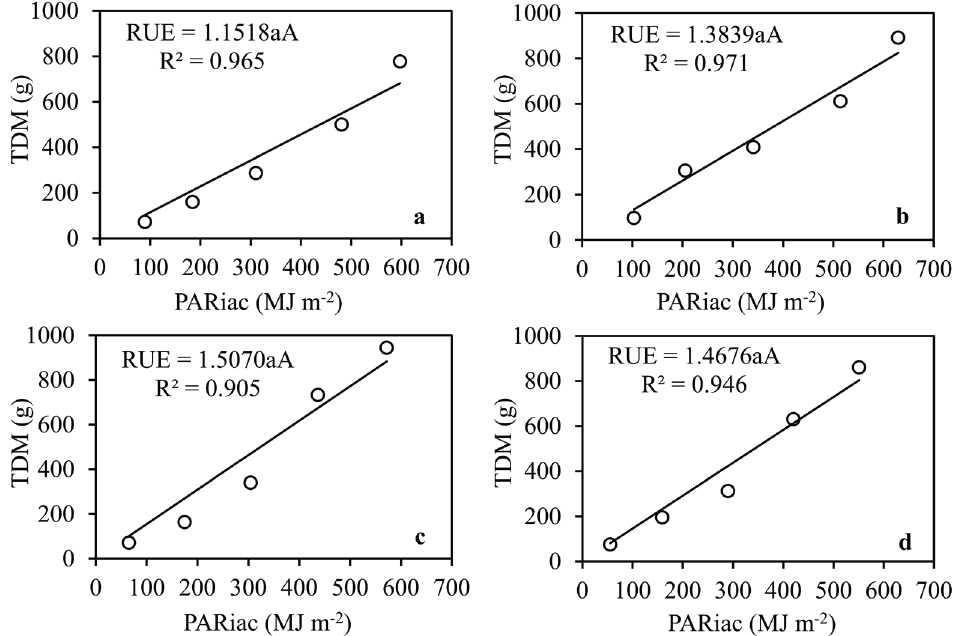
Figure 4 - relationship between accumulated intercepted photosynthetically active radiation (PAriac) and dry matter produced (TDM) in a field experiment in Frederico Westphalen, Brazil, with the soybean cultivars ‘ a ’ – TeC6029 and ‘ b ’ – NA6411 (crop year 2013/2014); ‘ c ’ – TeC6029 and ‘ d ’ – NA6411 (crop year 2014/2015). Means followed by the same letter, lowercase comparing the crop years and uppercase comparing cultivar not differ by Tukey test at 0.05 probability of